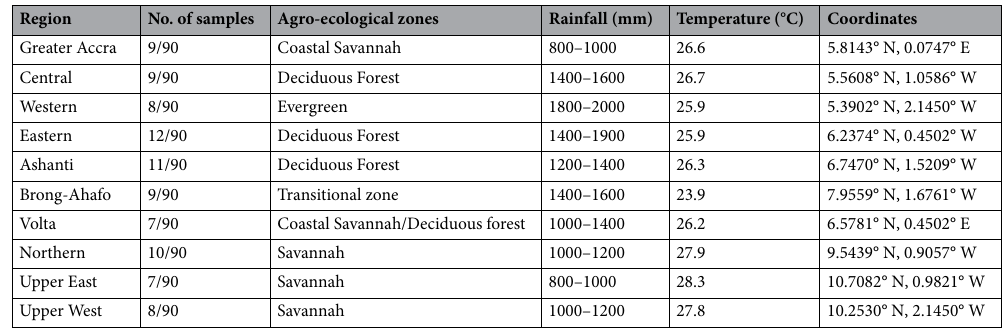
Table 1. Geographical locations and some attributes of the origin of